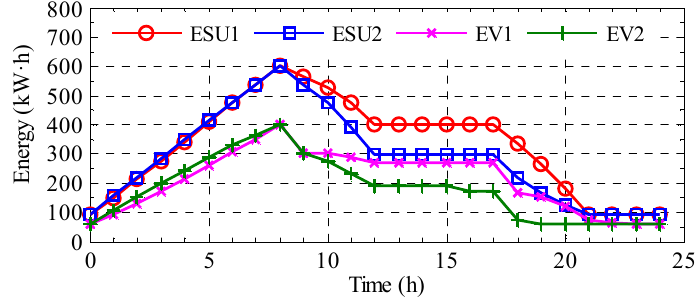
Figure 8. Energy of ESUs and EVs in 24